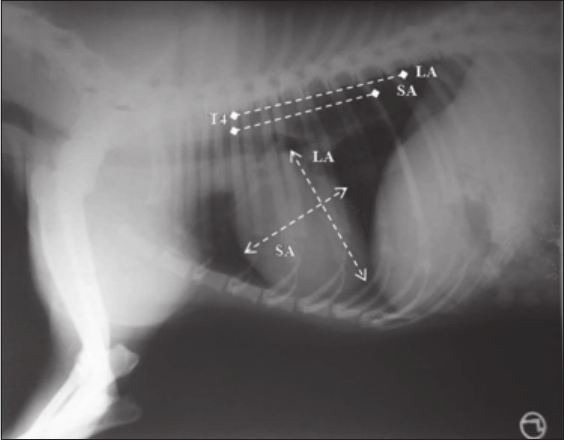
Figure-1: Long axis (LA) and short axis (SA) measurement of heart in lateral recumbency for calculation of VHS. T4 is the fourth thoracic